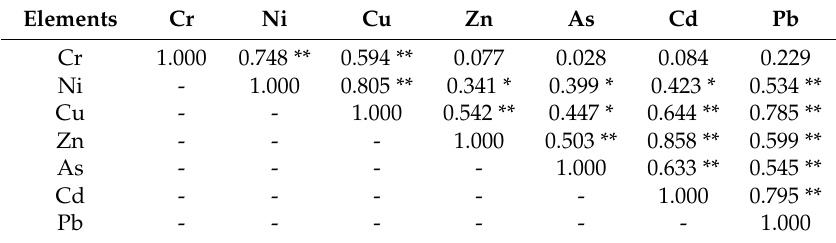
Table 6. Spearman correlation analysis between